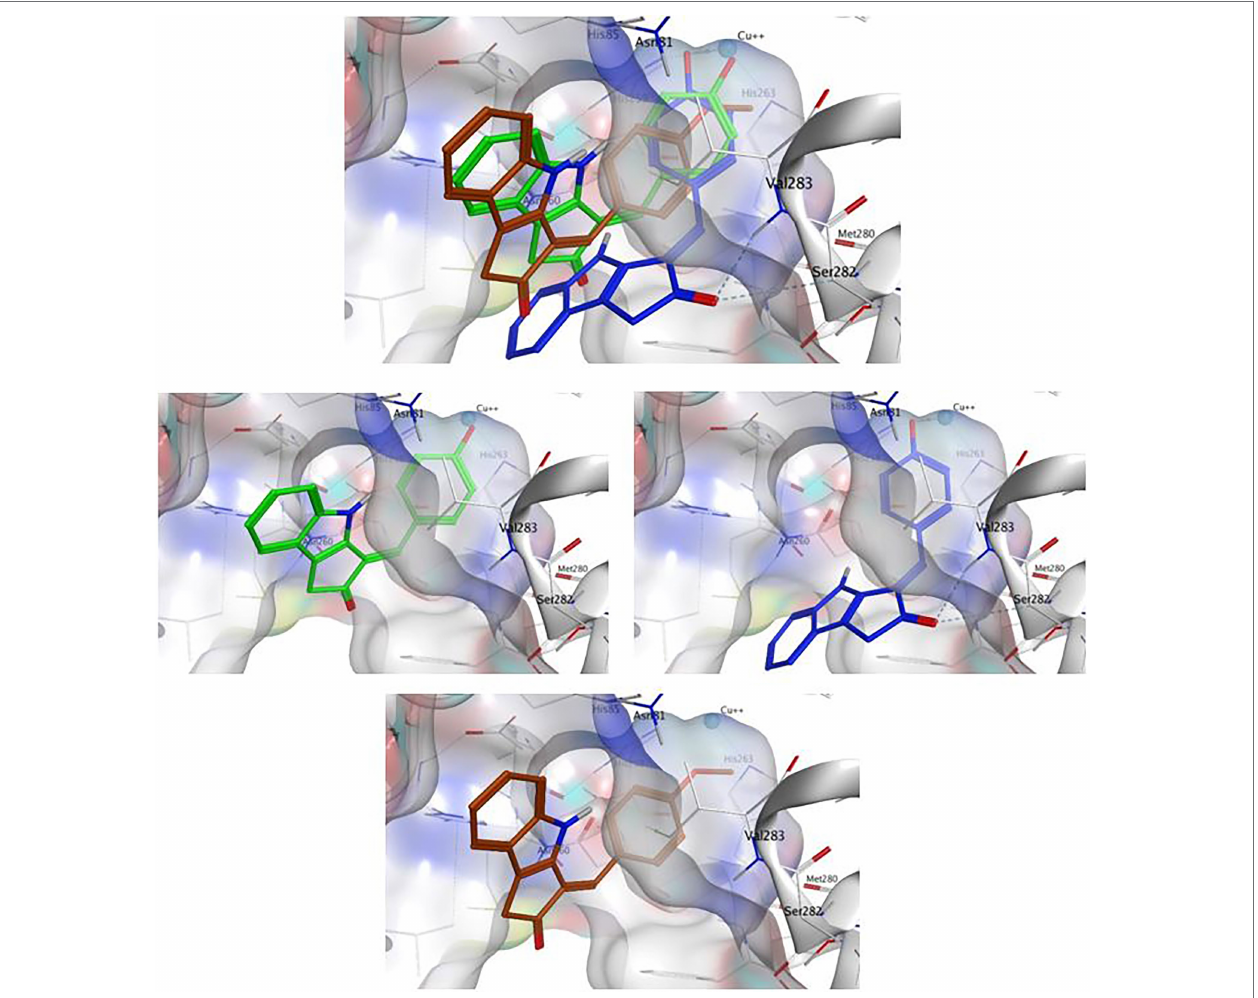
FIGURE 8 | The binding conformation of ScyM with best binding score ( 1 , green), ScyM with second-best binding score ( 1 , blue) and ScyM-OMe ( 4 , brown). Sub- panels were provided for each individual compound to better show their interaction with nearby residues. The cyan sphere represents the copper ion in contact with ligands in the binding pocket. Blue colored dashed lines represent hydrogen bonds between ligand and corresponding tyrosinase residues. Dockings of various ligands were performed separately but placed together in the same plot in the composite figure for visualization of spatial overlaps. The methoxylated monomer ScyM-OMe was no longer closely associated with the catalytic copper-binding